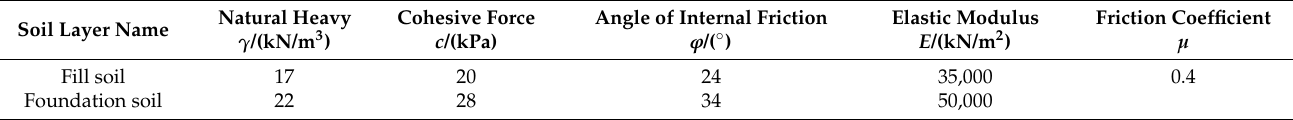
Table 1. Soil parameters of example 1.